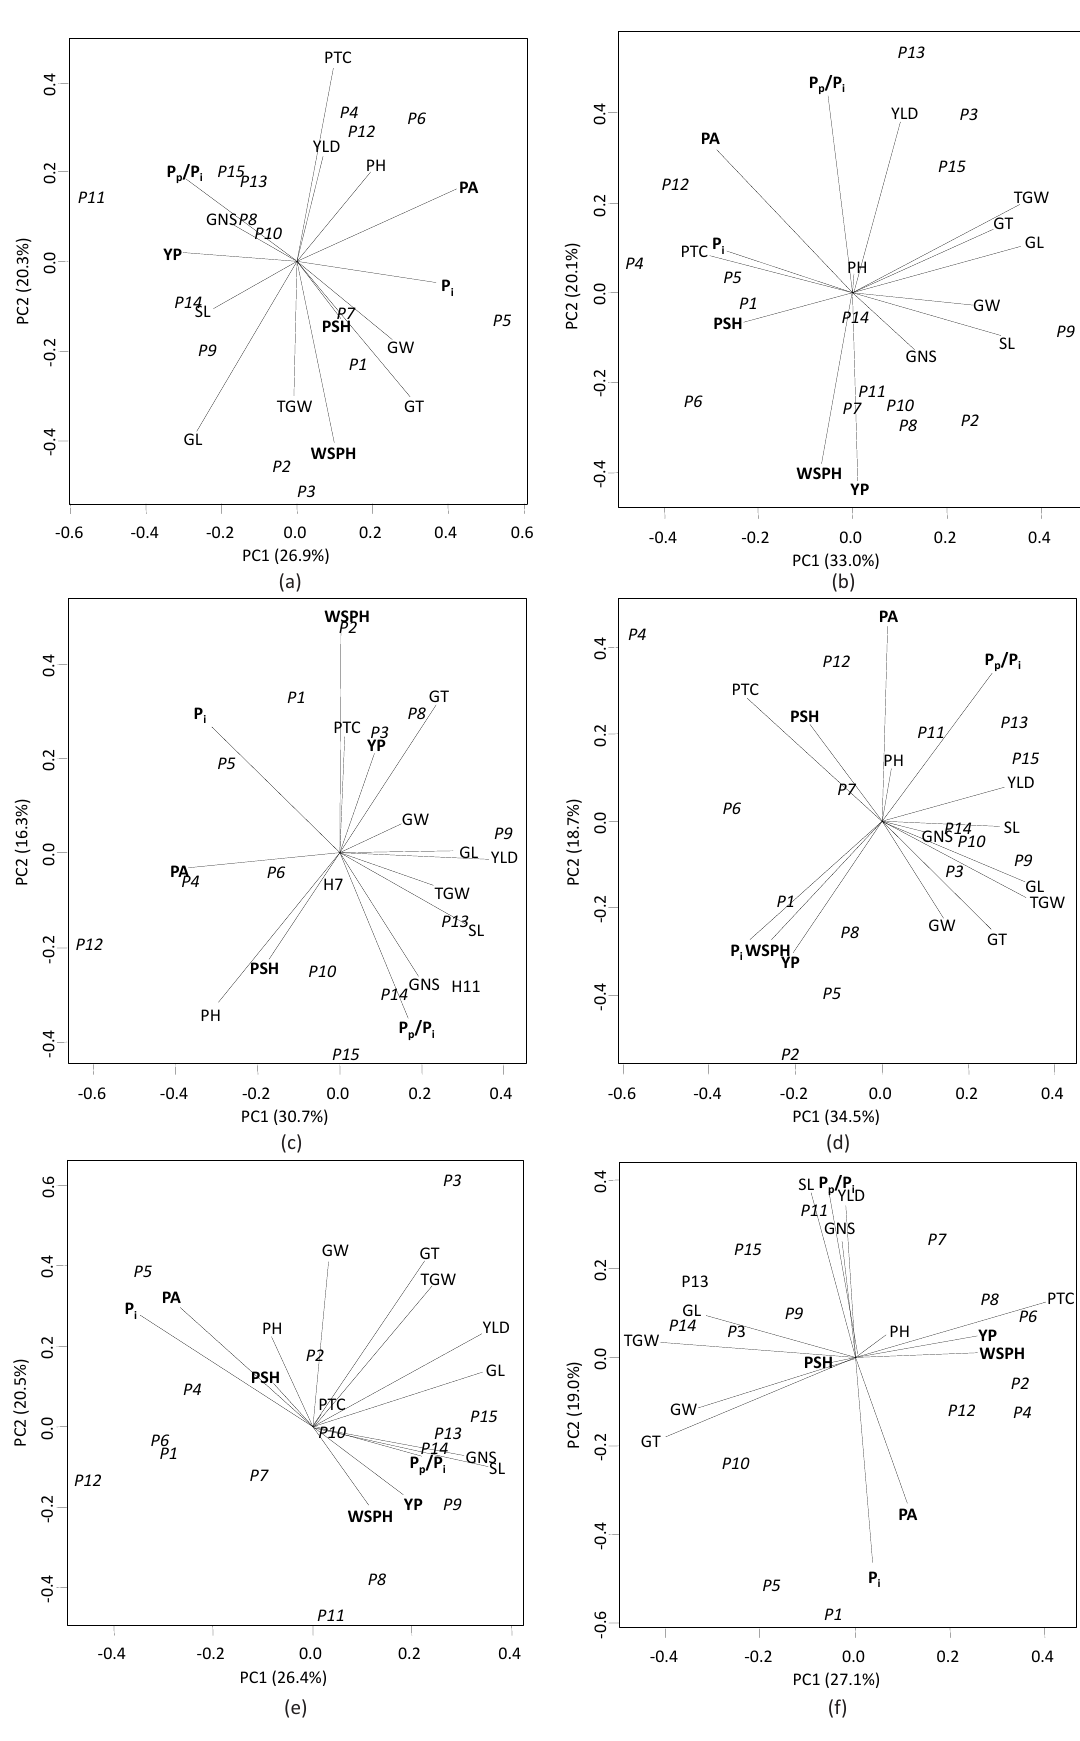
Fig. 1. Genotype by trait (GT) biplot of 15 bread wheat genotypes ( P 1- P 15) by nine agronomic and six chemical characteristics measured across six environments (Rimski Šančevi for 2010 – 2011 (a) and 2011 – 2012 (b) vegetation season, Zemun Polje for 2010 – 2011 (c) and 2011 – 2012 (d) vegetation season and Padinska Skela for 2010 – 2011 (e) and 2011 – 2012 (f) vegetation season). YLD = grain yield; TGW = thousand grain weight; PH = plant height; SL = spike length; GNS = grain number per spike; GL = grain length; GW = grain width; GT = grain thickness; PTC = productive tillering coefficient; PA = phytic acid; P phosphorus/inorganic phosphorus; YP = yellow pigment; WSPH = water soluble phenolics; PSH = free protein sulfhydryl